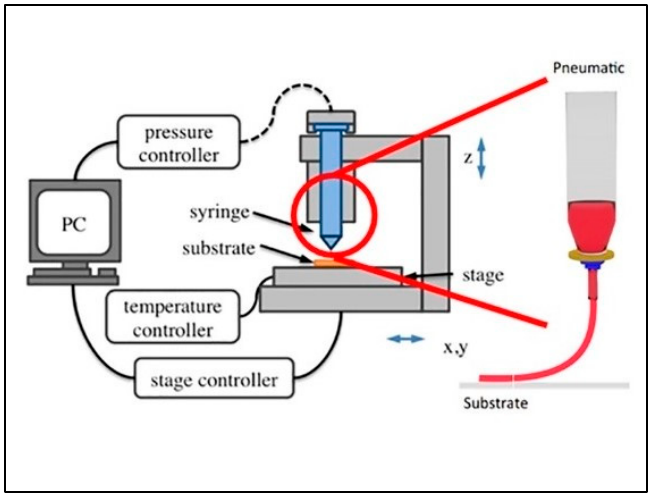
Figure 9. Schematic illustration of dispenser printer. Reproduced with permission from [75]. Copy- right Wiley Online Library, 2016.